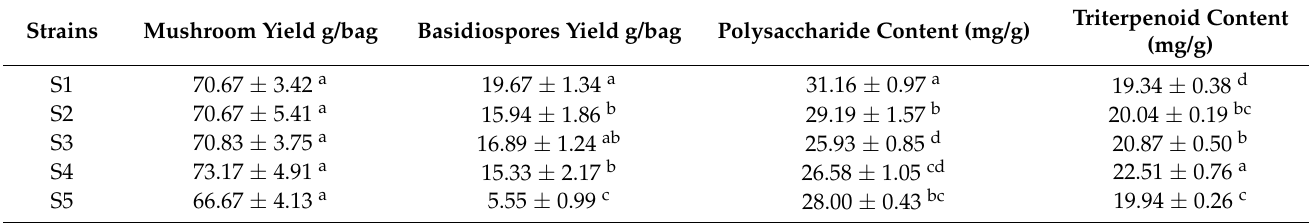
Table 1. Mushroom yield, basidiospore yield, and polysaccharide and triterpenoid content in isonu- clear alloplasmic strains S1–S5.